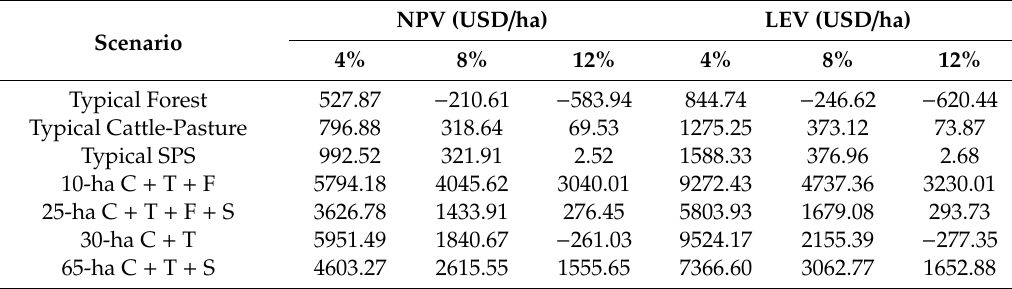
Table 3. Net present values (NPV) and land expectation values (LEV) of the evaluated